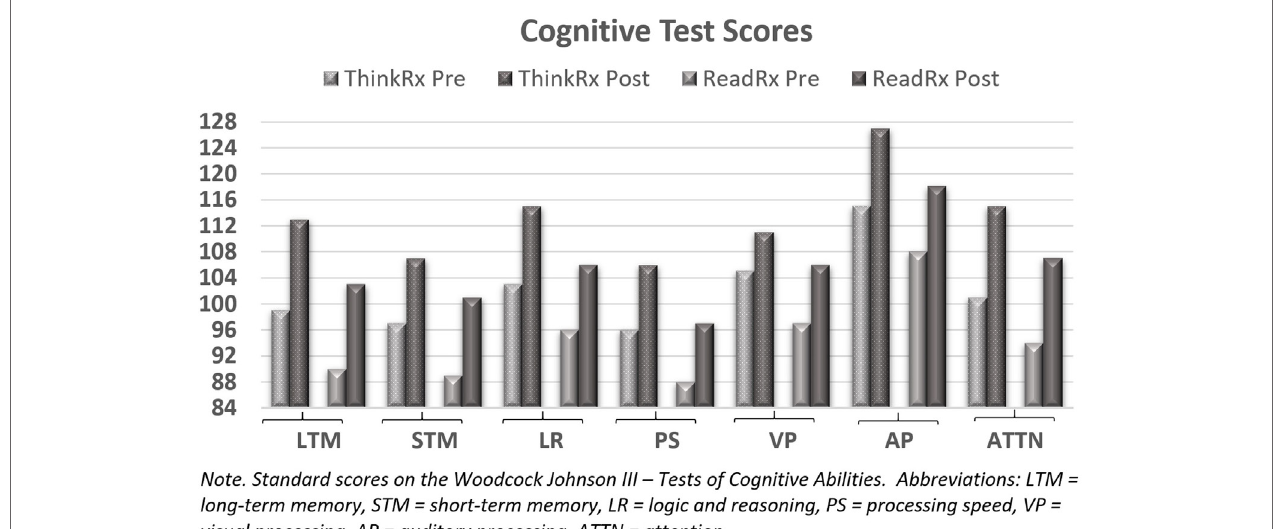
FigUre 4 | Cognitive test scores for both intervention